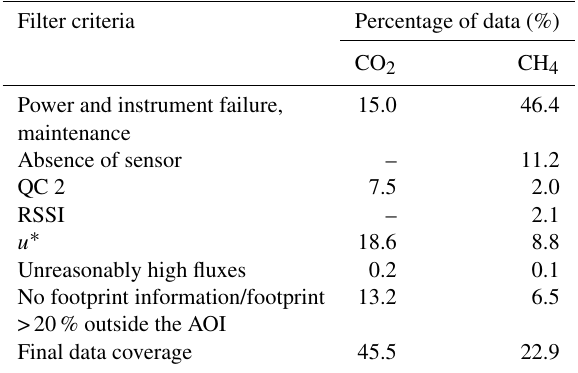
Table 1. Data loss and final data coverage during the observation pe- riod. CO 2 and CH 4 flux data were lost by power and instrument fail- ure and maintenance as well as quality control and footprint analy-